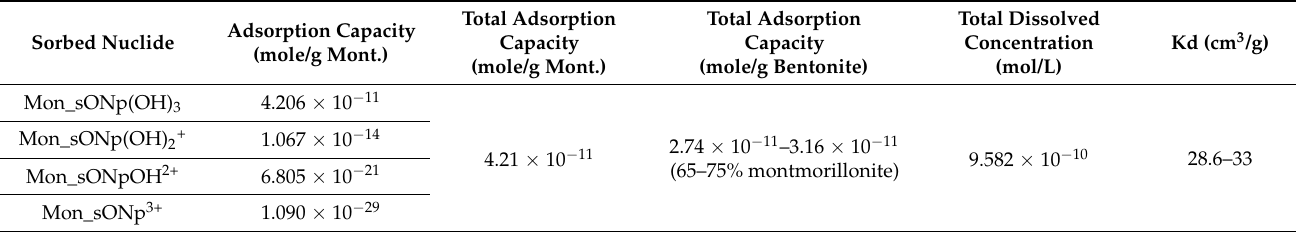
Table 6. Adsorption capacity, total adsorption capacity, total dissolved concentration and calculated Kd for neptunium in SCM. Adsorption Capacity Sorbed Nuclide (mole/g